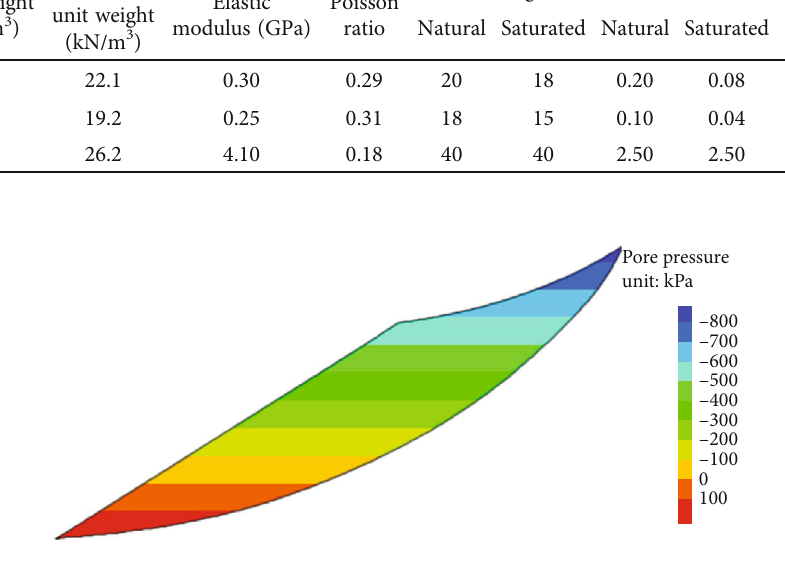
Figure 7: Distribution of initial pore water pressure.